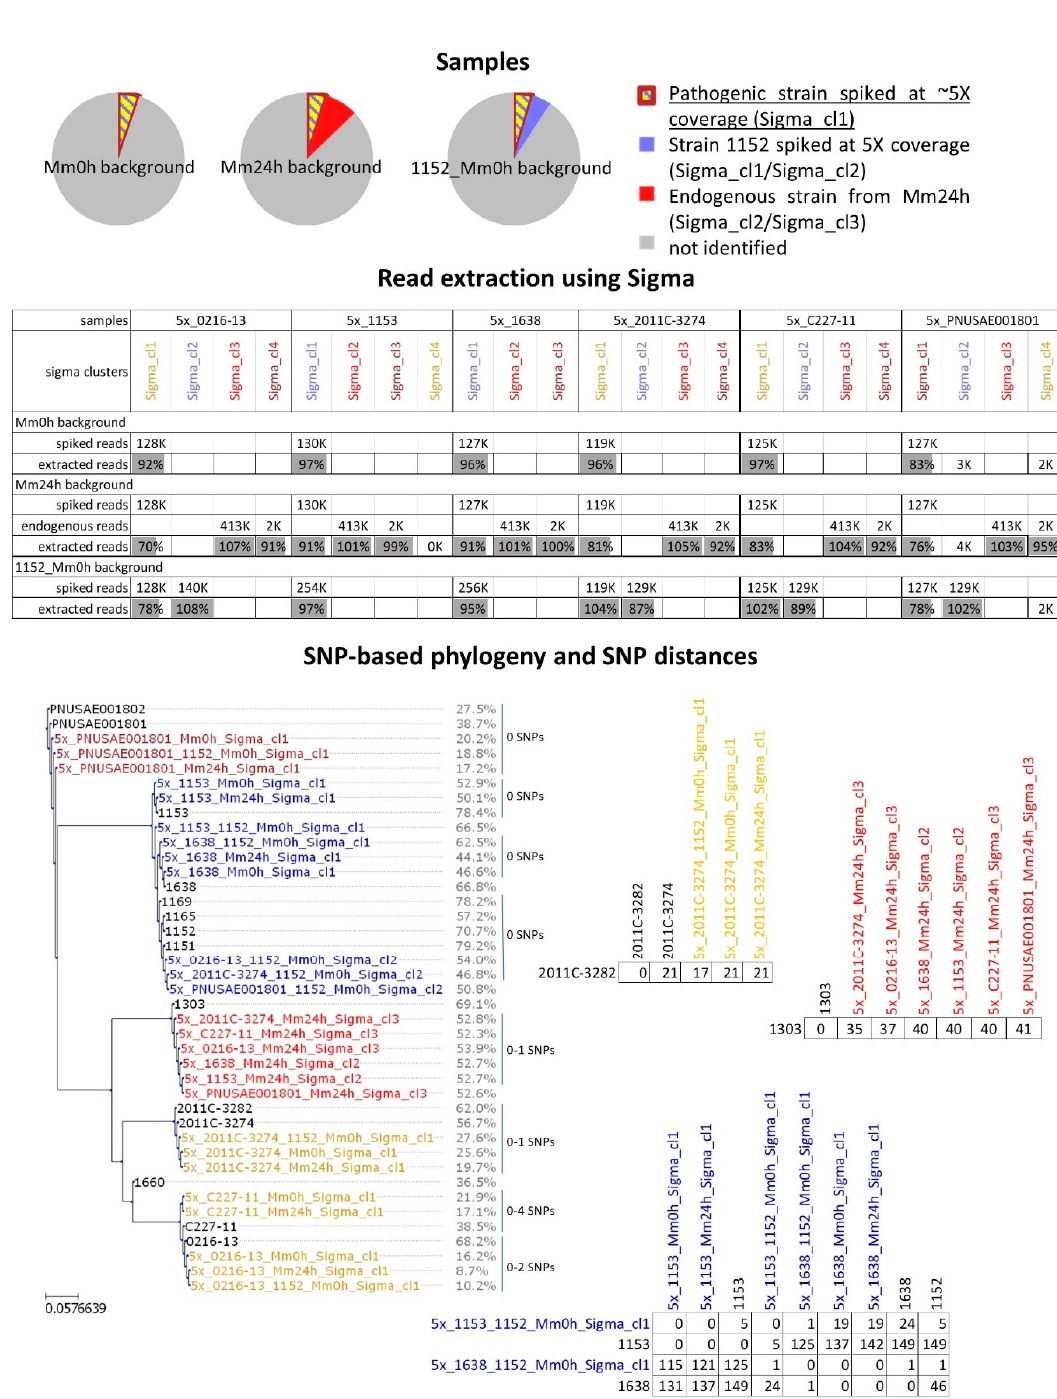
Figure 5. Strain-level analysis of in silico spiked metagenomic samples containing different pathogenic E. coli strains. Samples: the pie plots represent schematically the simulated metagenomic samples, consisting of reads of a pathogenic E. coli isolate (mixed color) in silico spiked at a ~5× coverage into the non-enriched minced meat sample containing no endogenous E. coli strains (Mm0h background), the enriched minced meat sample containing one more prevalent (red) and one negligible (not included in figure) endogenous E. coli strains according to Sigma (Mm24h background), and the non-enriched minced meat sample that has been previously in silico spiked with reads of a pathogenic E. coli isolate TIAC1152 (blue) at a coverage of 5× (1152_Mm0h background). Read extraction using Sigma: number of reads of a pathogenic E. coli isolate and isolate